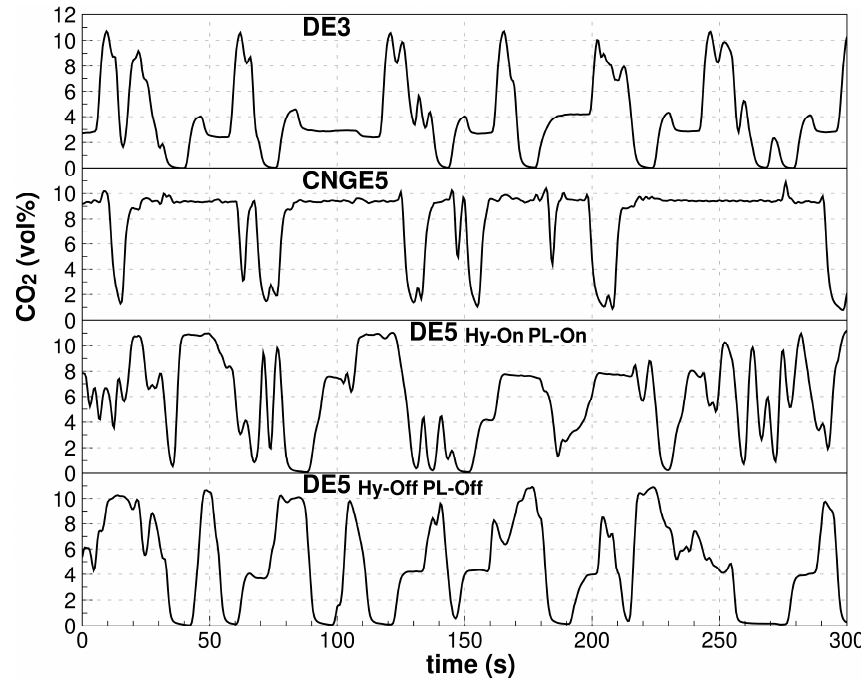
Figure 7. CO 2 concentration vs time measured of the DE3 bus, CNGE5 bus, and DE5 bus in hybrid mode with power limiter on and in non-hybrid mode with power limiter